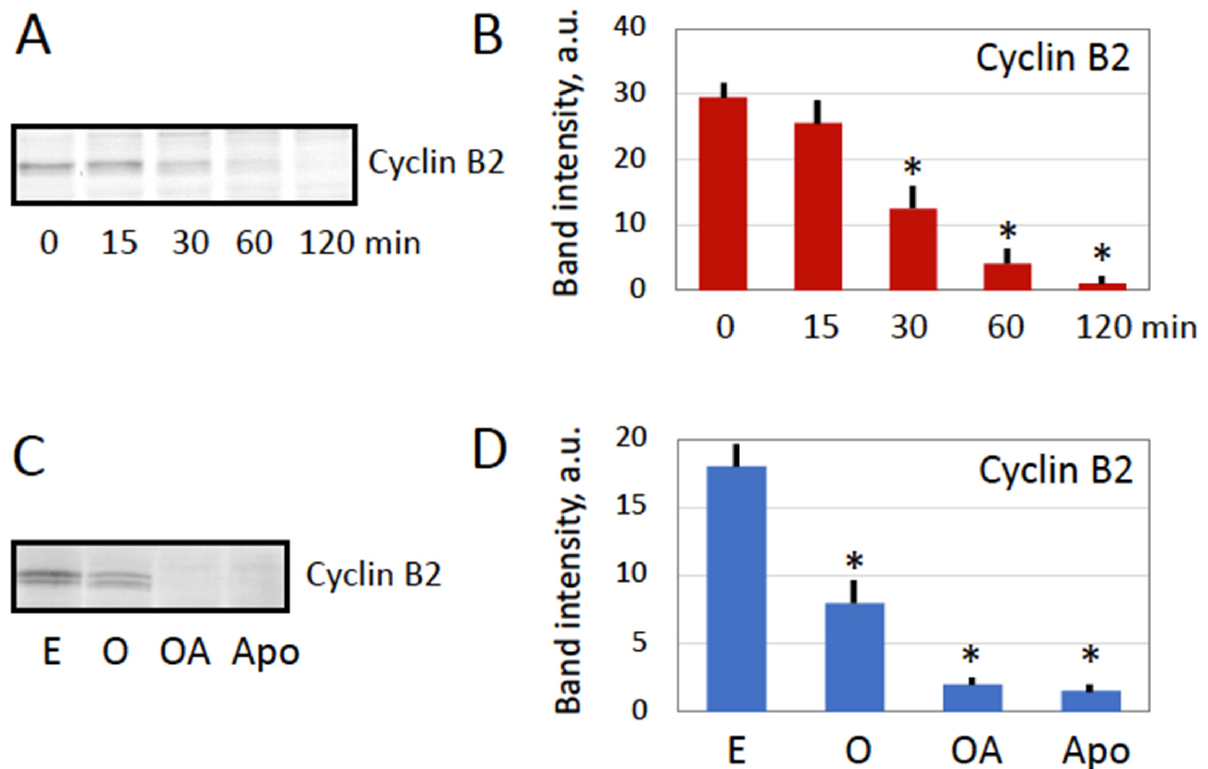
Figure 2. Cyclin B degradation in overactivated frog eggs. Cyclin B contents in the overactivated Xenopus eggs incubated with hydrogen peroxide for different times is presented in panels ( A , B ). Cyclin B contents in metaphase II-arrested (E), overactivated (OA), apoptotic (Apo) eggs and oocytes (O) are presented in panels ( C , D ). Panels ( B , D ) show quantification of the blots displayed in panels ( A , C ). In panels ( C , D ), overactivated eggs were collected after 1 h peroxide treatment, and apoptotic eggs were analyzed within 24 – 30 h of ovulation. The experiment was repeated with three separate batches of eggs obtained from different animals and the result of a single-batch experiment is shown. Bars in panels ( B , D ) represent SD values of the mean obtained in four measurements of the same experiment. Asterisks in the panels indicate statistical difference ( p < 0.05) from untreated control eggs (0 min in panel ( B ), and E in panel ( C )).